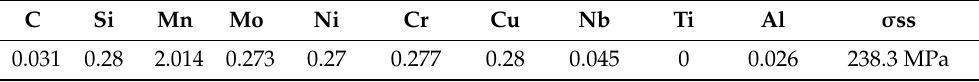
Table 6. Calculation results of solution element content and solution strengthening (wt.%).